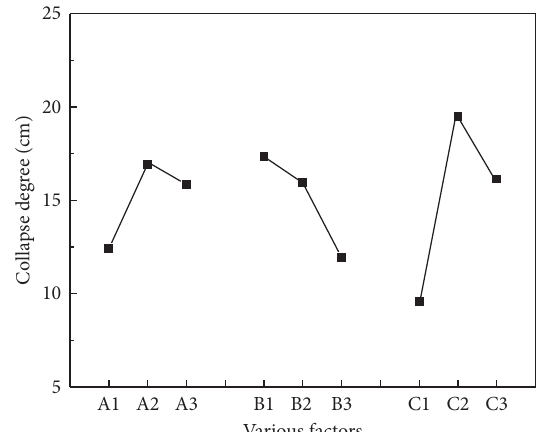
Figure 8: The tendency of compressive strength and factor level of paste